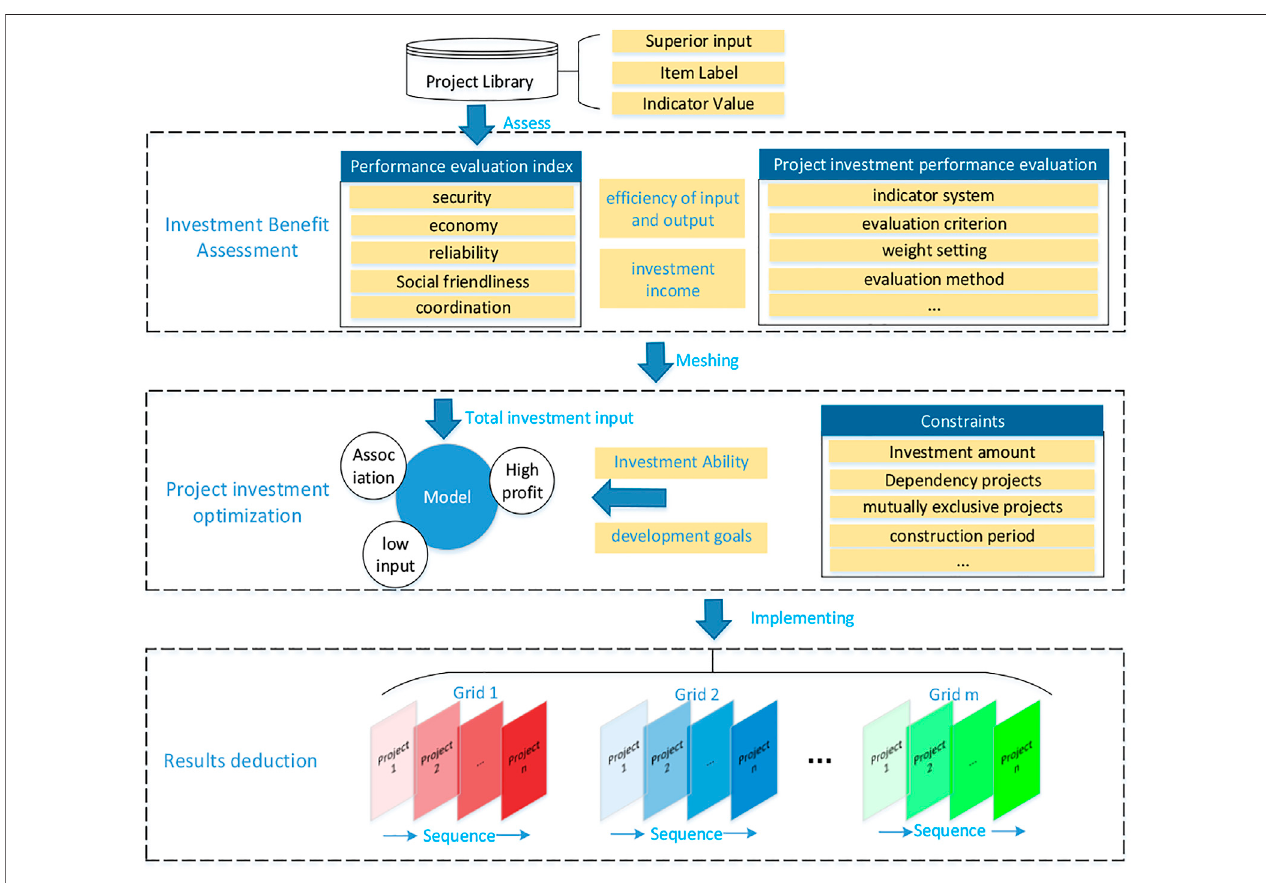
FIGURE 1 | Label-based project